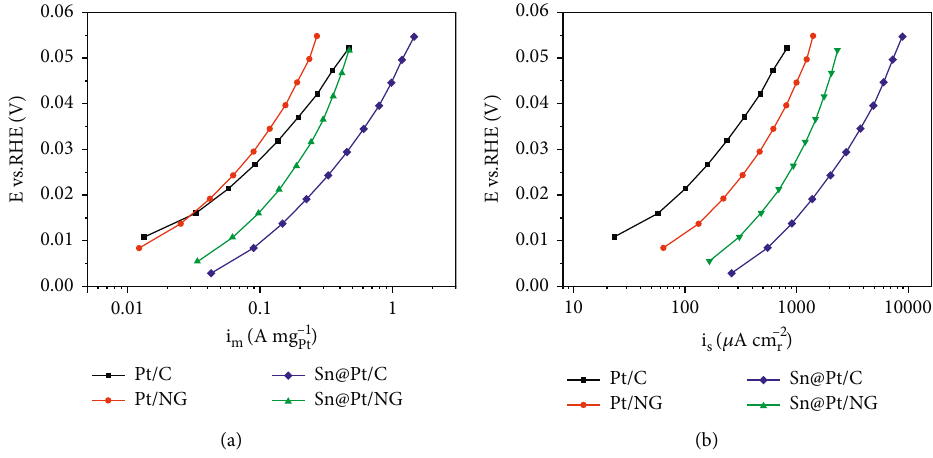
Figure 7: Tafel plots of (a) mass and (b) specific activity of the nanocatalysts for the